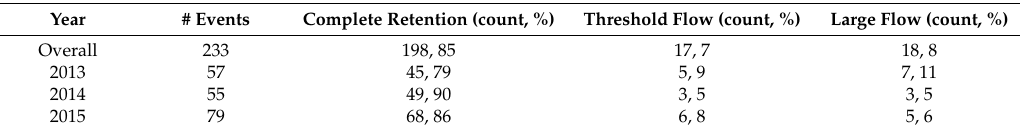
Table 3. The number and percent of total events separated into different categories of flow severity, which is based on